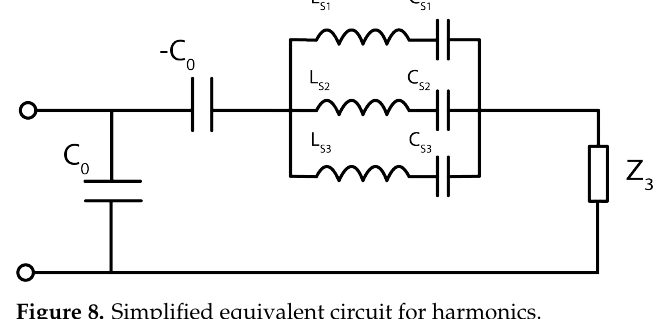
Figure 8. Simplified equivalent circuit for harmonics.